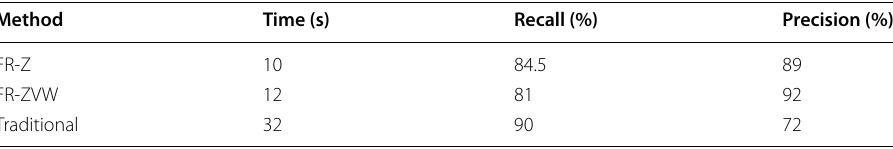
Table 4 The comparison results of identification